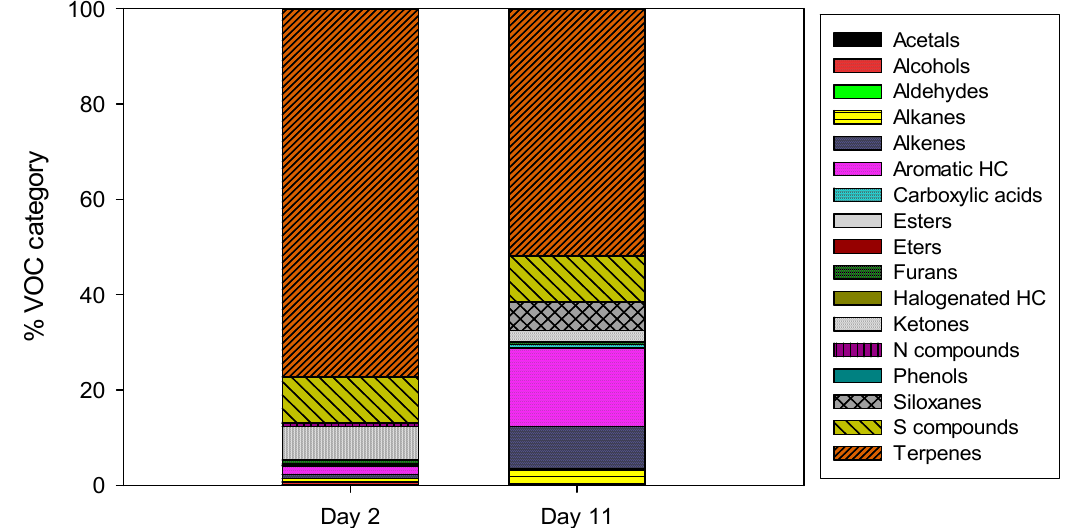
Figure 5. Distribution of the different volatile organic compound (VOC) categories found in the off gases of the composting reactor, expressed in relative abundance with respect to the whole sample.